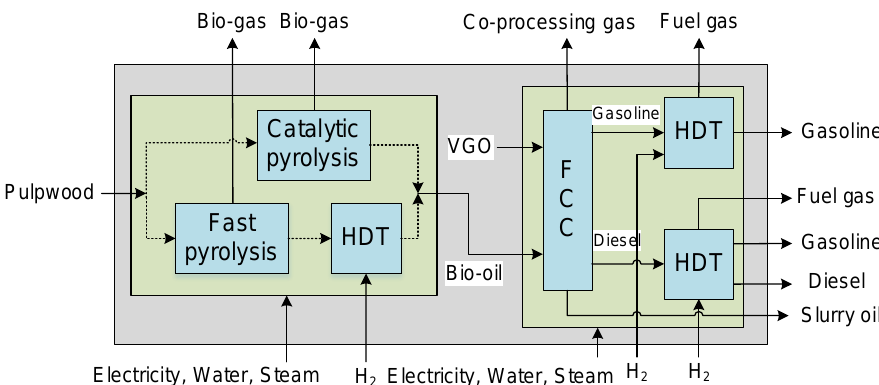
Figure 2. System boundary of the co-processing scheme.